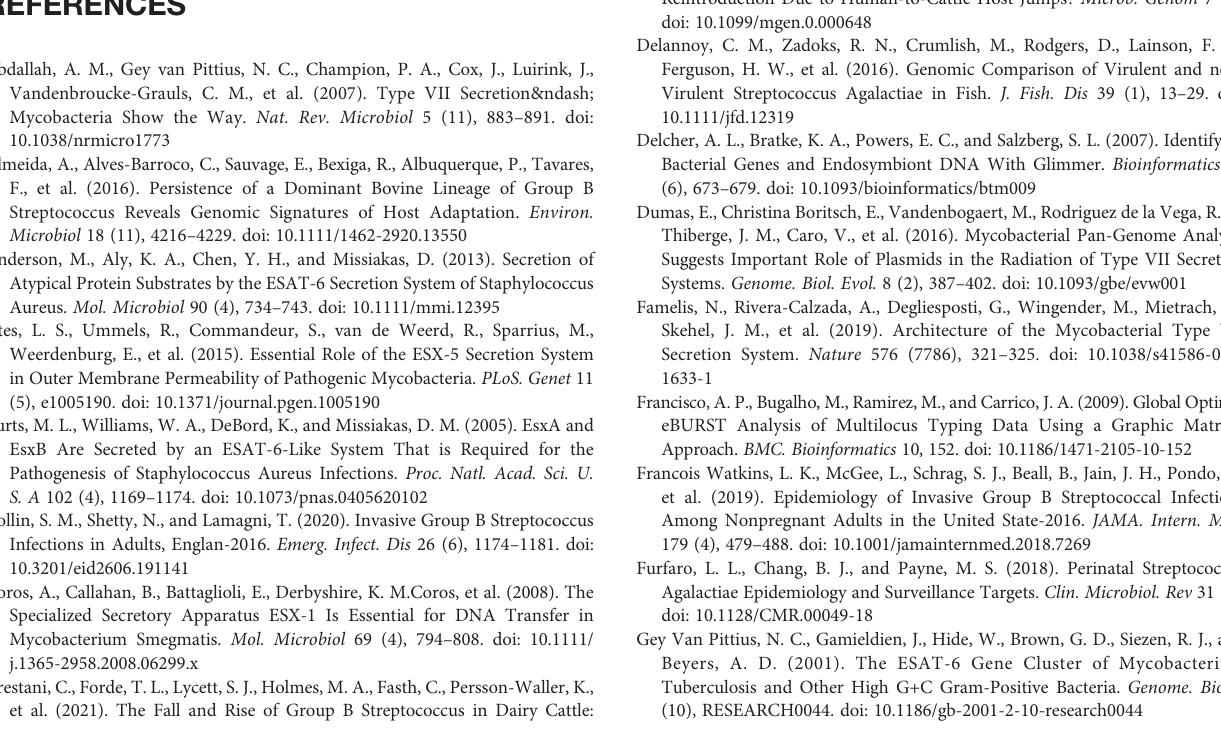
Supplementary Table 1 | Clinical isolates. Supplementary Table 2 | Public data